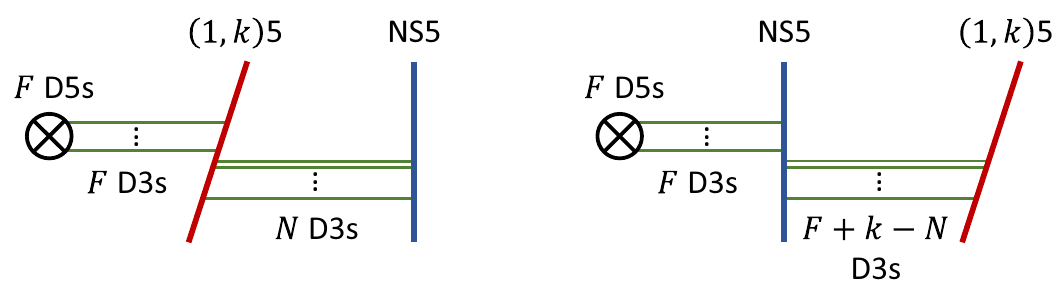
Figure 1 . The brane configurations which correspond to (B.4) (left) and (B.18) (right). Both the brane configurations are related with each other by the Hanany-Witten move. The NS5-brane and the D5-brane span the (0 , 1 , 2 , 3 , 4 , 5) directions and (0 , 1 , 2 , 7 , 8 , 9) directions, respectively. The (1 , k ) 5-brane spans the (0 , 1 , 2 , 3 / 7 , 4 / 8 , 5 / 9) directions with appropriate angles. The D3-branes span the (0 , 1 , 2 , 3)